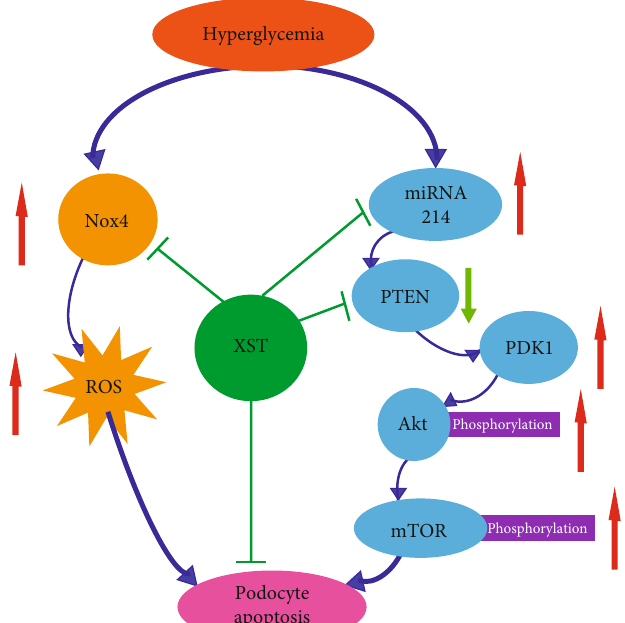
Figure 6: Graphic representation of the mechanism of Xuesaitong (XST) against podocyte apoptosis partly through modulation of the PTEN- PDK1-Akt-mTOR pathway and Nox4